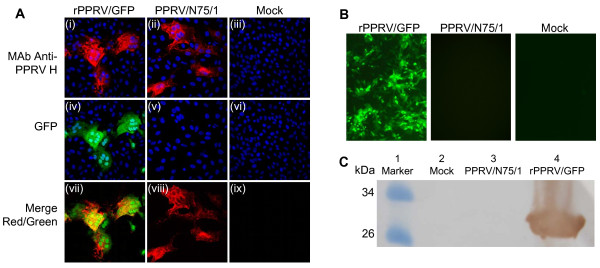
Replication of and GFP expression by rPPRV/GFP in Vero cells. (A) Cells infected with either rPPRV/GFP (i, iv, vii) or PPRV/N75/1 (ii, v, viii), or mock infected (iii, vi, ix), were fixed and labeled for the presence of PPRV glycoprotein H (red); GFP was detected by its natural fluorescence. Cells were counterstained with DAPI to show the nuclei. (B) GFP expression in live, PPRV/N75/1- and rPPRV/GFP-infected Vero cells was observed by direct observation of unfixed cells 2 days post infection. (C) Lysates of Vero cells that had been infected with PPRV/N75/1 or rPPRV/GFP were analyzed by Western blotting using mouse anti-GFP monoclonal antibody. Mock-infected Vero cells were used as a controls.